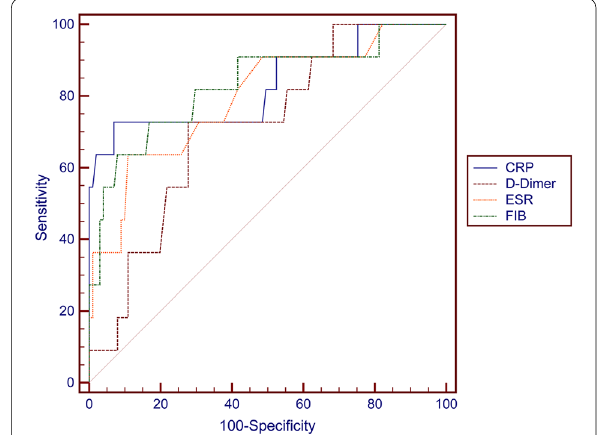
Fig. 1 ROC curves of the serum CRP, ESR, plasma D-dimer, and fibrinogen values for predicting the clinical success of the